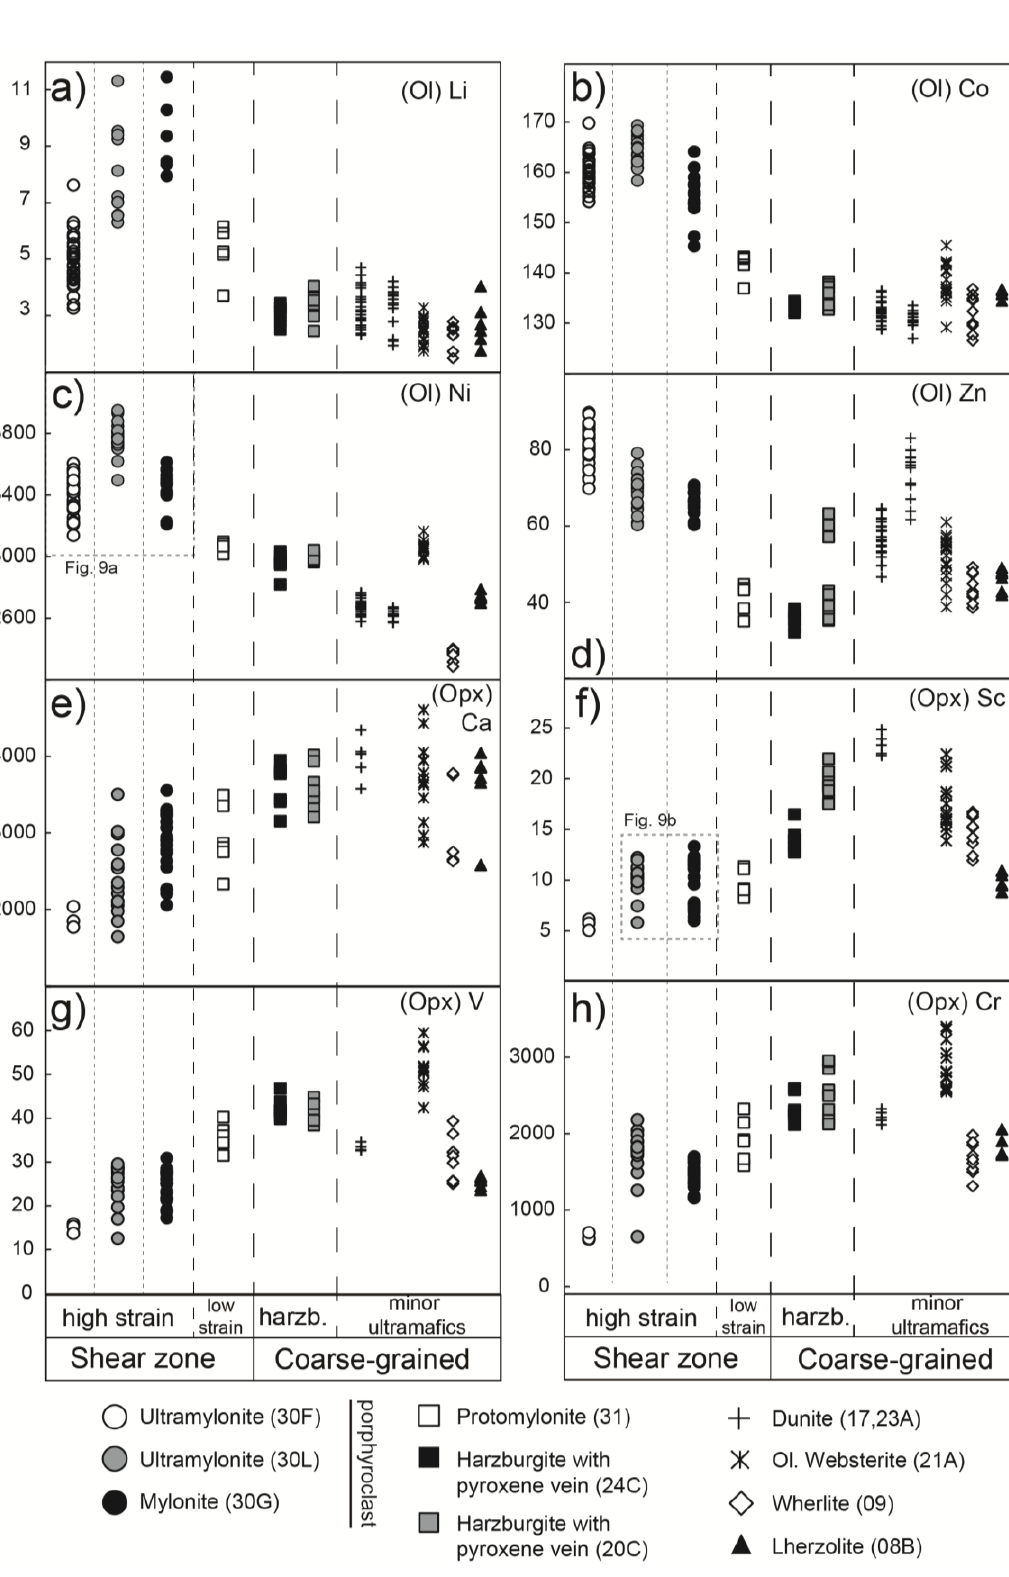
Figure 7. Trace-element concentrations (ppm) in mineral phases of Finero Ph-Pd samples. ( a , b , c , d ) Li, Co, Ni, Zn content in olivine; ( e , f , g , h ) Ca, Sc, V, Cr content in orthopyroxene. Dashed boxes in ( c ) and ( f ) refer to Figure 9a,b respectively.